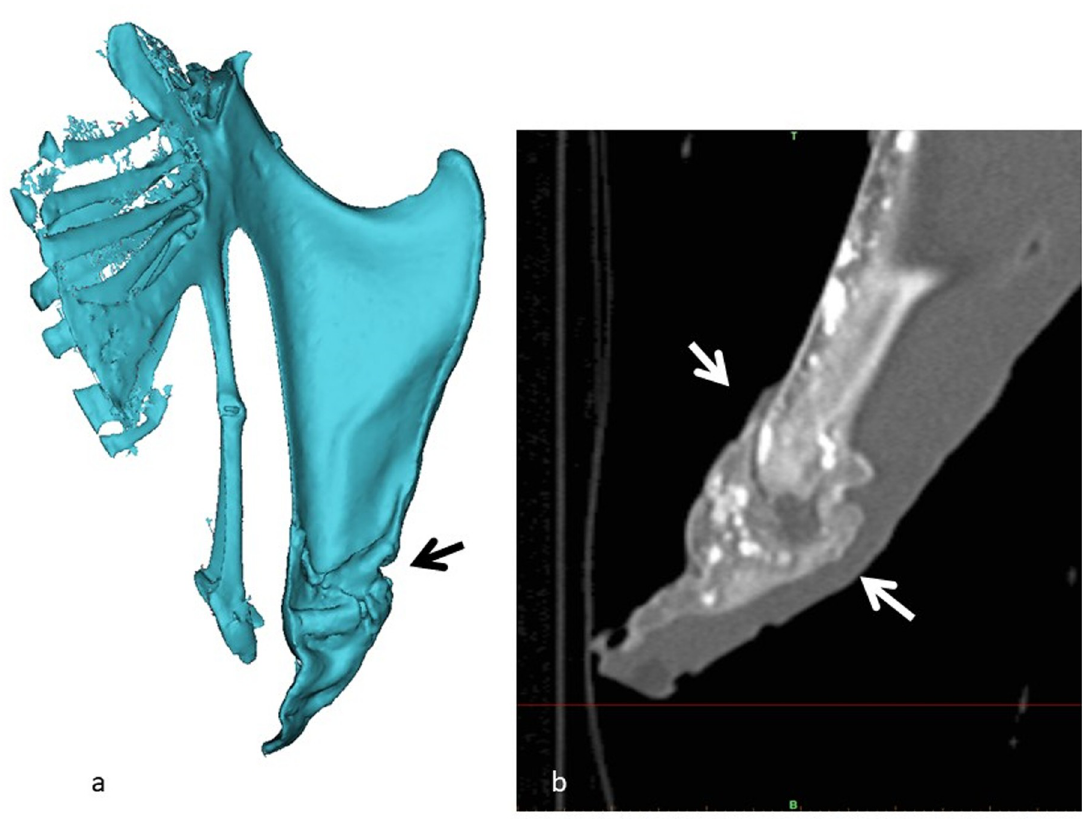
Fig 5. 3D model (a) and CT image (b) of a 75+-week hen showing multiple fractures and the so-called pseudoarticulation